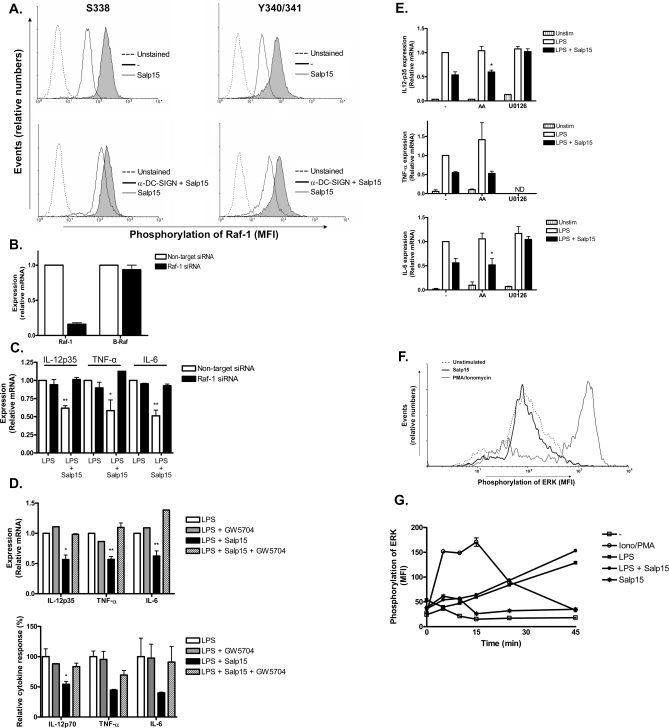
DC Cytokine Inhibition by Salp15 Is Raf-1-Dependent(A) Salp15 induces phosphorylation of Raf-1. DCs were pretreated with medium or with blocking anti-DC-SIGN antibodies (AZN-D2) before addition of 25 μg/ml Salp15. Intracellular phosphorylation of Raf-1 was measured by flow cytometry using rabbit anti-phospho-c-Raf (Ser338) mAb and rabbit anti-c-Raf (Tyr341) pAb.(B) Raf-1 was specifically silenced by siRNA. DCs were transfected with 100 nM siRNA (Raf-1 or non-targeting siRNA as a control). Raf-1 and B-Raf mRNA was quantified by real-time PCR using gene-specific primers. Relative mRNA expression was corrected for GAPDH expression.(C) RNAi-mediated silencing of Raf-1 abrogates Salp15-mediated cytokine inhibition. siRNA-treated cells were stimulated for 6 h with LPS in the presence or absence of 25 μg/ml Salp15. Cytokine gene expression was measured by real time PCR and corrected for GAPDH expression. Relative mRNA expression of LPS-stimulated non-targeting siRNA-treated cells was set at 1.(D) Raf-1 inhibition by GW5704 abrogates Salp15-mediated cytokine inhibition. DCs were incubated with 1 μM GW5704, or DMSO as a negative control, for 2 h before stimulation with LPS for 6 h (mRNA) or 18 h (protein) in the presence or absence of 25 μg/ml Salp15. Cytokine gene expression was measured by real time PCR and corrected for GAPDH expression. Relative mRNA expression of LPS-stimulated cells was set at 1. For protein levels, LPS was set at 100%, which is representative of 133 ± 17 pg/ml IL-12p70; 9,188 ± 850 pg/ml TNF-α, and 1,563 ± 800 pg/ml IL-6. GW5704 alone did not induce cytokine production (unpublished data).(E) MEK1/2-inhibitor U0126 blocks Salp15-mediated cytokine inhibition. DCs were pre-incubated for 2 h with anacardic acid (AA), an inhibitor of the histone acetyltransferases p300 and CBP, U0126, an inhibitor of MEK1 and MEK2, or DMSO as a negative control. Cells were stimulated as described in (C) and cytokine gene expression was measured by real time PCR and corrected for GAPDH expression. Relative mRNA expression of LPS-stimulated cells was set at 1.(F and G) Salp15 does not induce phosphorylation of ERK. DCs were stimulated for 0 to 45 min with Salp15 (25 μg /ml), LPS, or PMA/Ionomycin as a positive control. Phosphorylation of ERK was determined by flow cytometry using a rabbit anti-phospho-p44/42 MAPK (Thr202/Tyr402) mAb.Bars represent the mean of at least three independent experiments ± SE. For (C) mRNA expression levels in non-target siRNA-treated DCs activated with LPS + Salp15 were compared to Raf-1 siRNA-treated DCs activated with LPS + Salp15. In (D) and (E) levels in DCs treated with LPS + Salp15 were compared to levels in DCs treated with LPS + Salp15 in the presence of the indicated inhibitor. A two-sided unpaired Student t-test was applied and a p-value < 0.05 was considered statistically significant. (*) 0.01 < p < 0.05; two asterisks (**) 0.001 < p < 0.01.